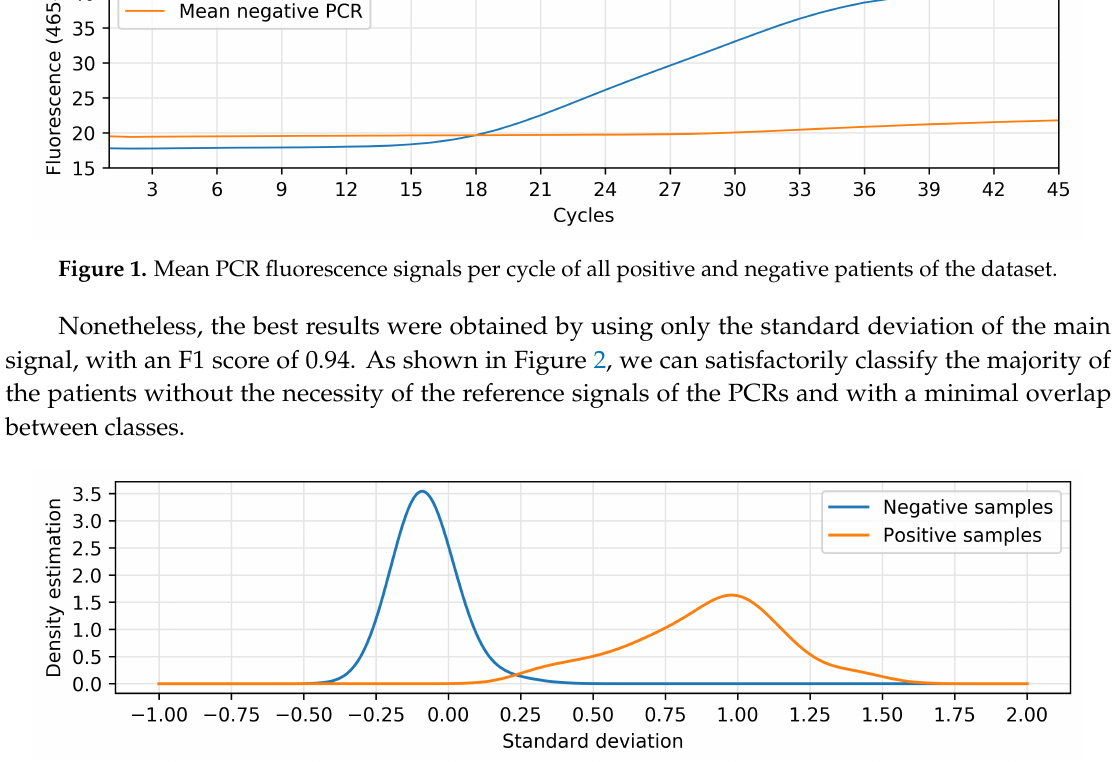
Figure 2. Resulting density estimation for the trained classifier using a kernel bandwith of